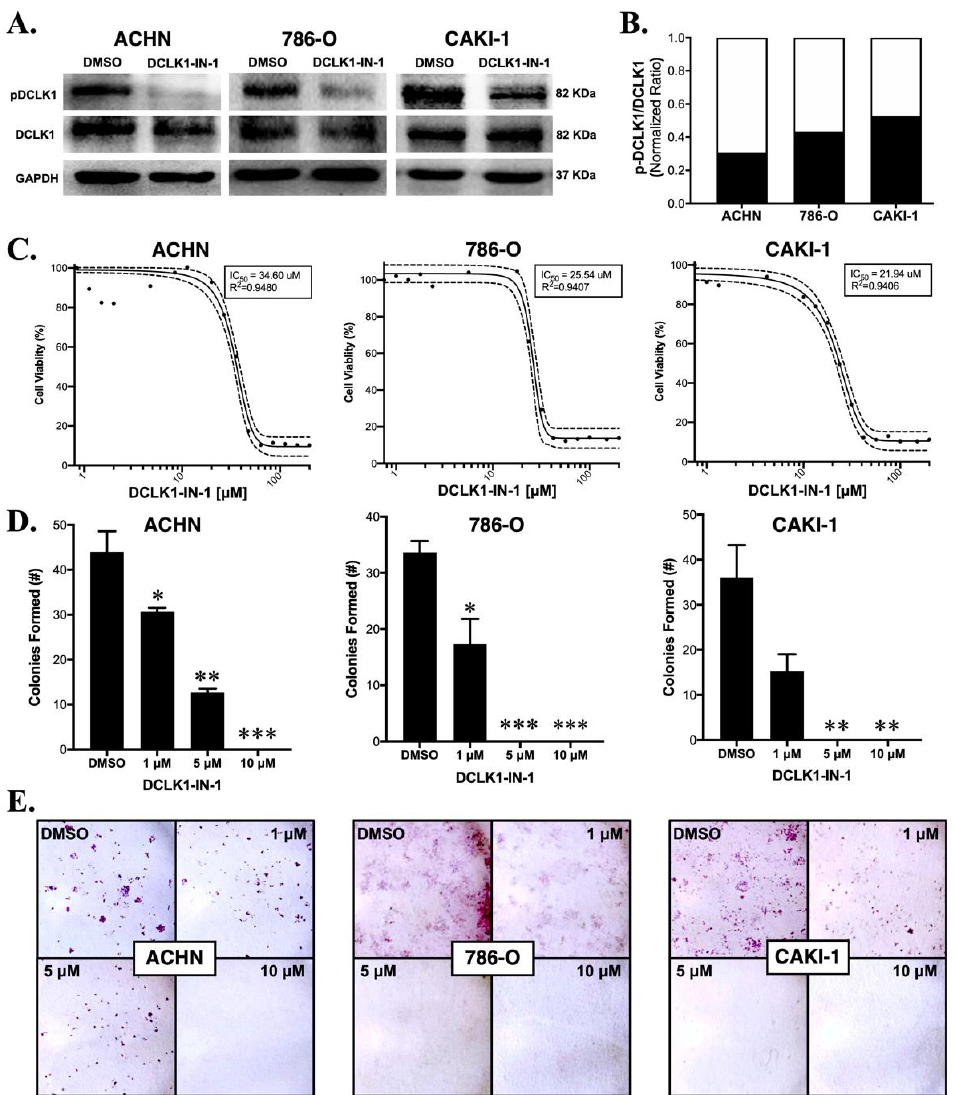
Figure 1. DCLK1-IN-1 inhibits DCLK1 phosphorylation and colony formation in RCC cell lines. ( A ) Immunoblots demonstrating a strong decrease in phosphorylation of DCLK1 serine 337 by DCLK1-IN-1 (10 µ M) when added to serum-starved RCC cells together with FBS for their stimulation, with incubation at the indicated time periods: ACHN (48 h), 786-O (24 h), and CAKI-1 (48 h). ( B ) Western blot band densitometry of phospho-DCLK1 normalized to total DCLK1 after DCLK1-IN-1 treatment (black bar) relative to dimethylsulfoxide (DMSO) vehicle control (white bar) in the ACHN, 786-O, and CAKI-1 RCC cell lines. ( C ) MTT cell viability assay results and IC 50 curves for ACHN (48 h), 786-O (48 h), and CAKI-1 (72 h) RCC cells, demonstrating a lack of notable cytotoxic/anti-proliferative effects at concentrations ranging up to 10 µ M. ( D ) Quantification of the mean number of colonies formed after 10 days following a single dose of DCLK1-IN-1 (1, 5, or 10 µ M) or DMSO vehicle control, demonstrating a significant reduction in clonogenic capacity after DCLK1-IN-1 treatment in ACHN, 786-O, and CAKI-1 RCC cells (* p < 0.05, ** p < 0.01, *** p < 0.001 vs. DMSO). ( E ) Representative figures of colony formation assays quantified in ( D